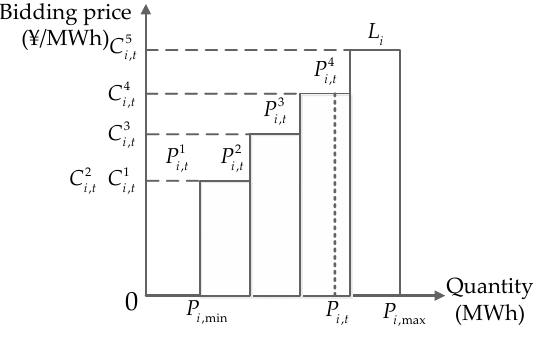
Figure 2. Multi-segment bid curve for conventional units (K = 5).